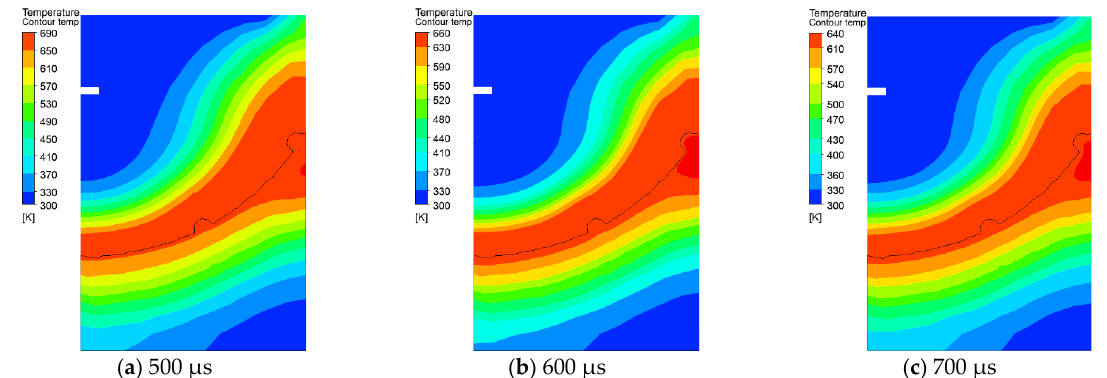
Figure 11. The temperature field changes at different moments.